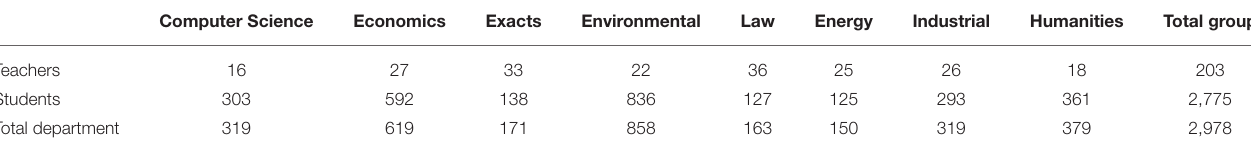
TABLE 1 | Description of the